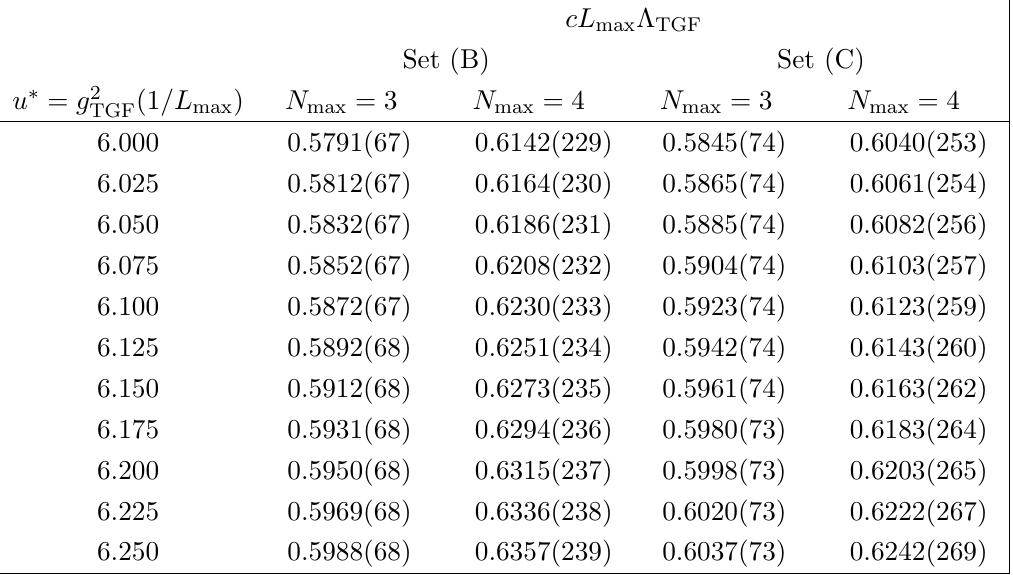
Table 5 . cL max (cid:3) TGF for each u (cid:3)